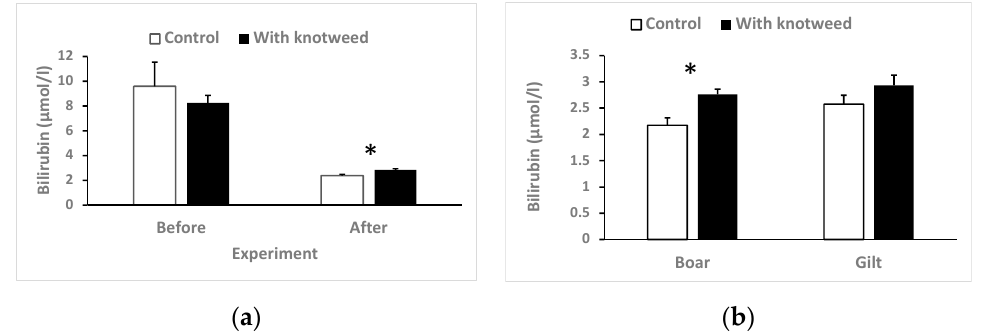
Figure 10. Total serum bilirubin in all animals at the beginning and the end of the experiment ( a ) and according to sex ( b ) in the experimental group of pigs (fed on knotweed) and the control group of pigs at the end of the experiment. Means + SEM. Difference significant on p < 0.05 marked by an asterisk.